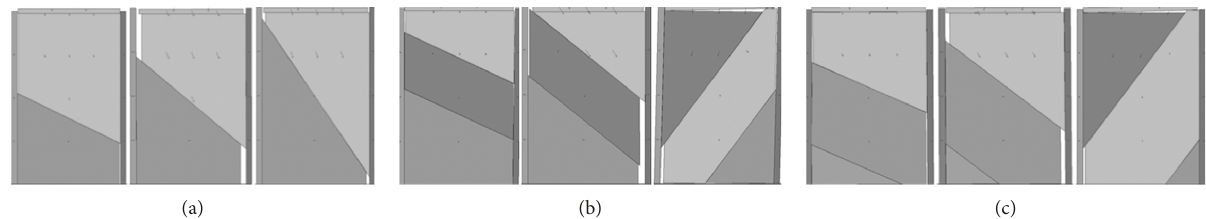
Figure 1: Failure maps of samples under numerical simulation. (a) Different dip angles. (b) Spacing with 30mm. (c) Spacing with 45mm.